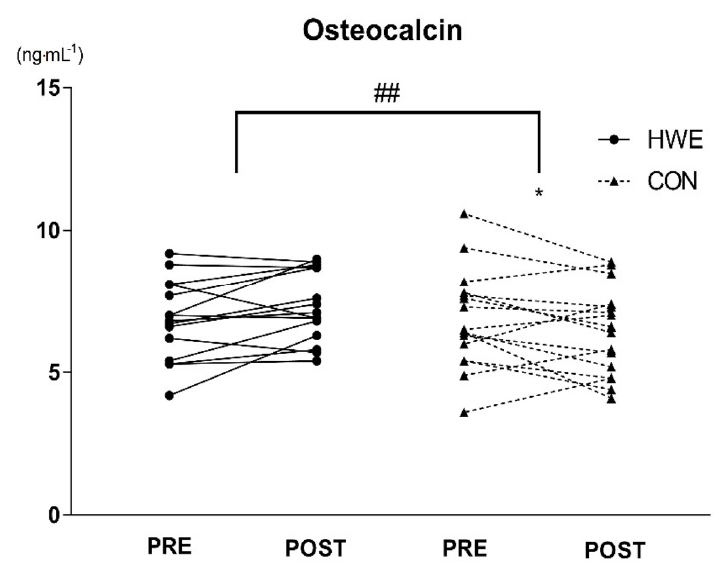
Figure 2. Osteocalcin before and after the four-month exercise program. For osteocalcin, statistical analyses revealed a decrease between pre- and post-tests in the CON group. HWE: high-impact weight-bearing exercise, CON: control. Significant difference between pre- and post-tests, * p < 0.05. Significant interaction effect, ## p <